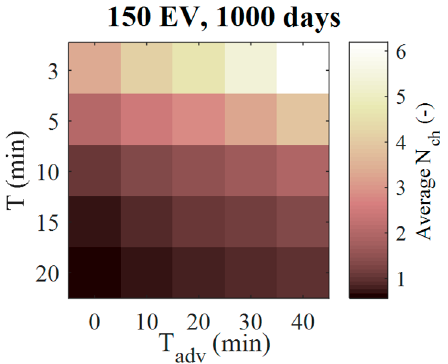
Figure 11. Average number of booking changes, with 150 EV.